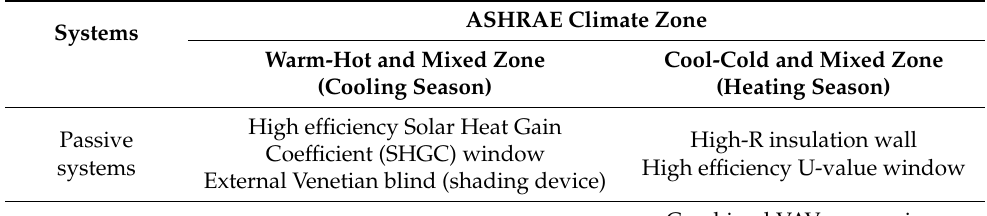
Table A2. Design strategies for saving energy in different climate